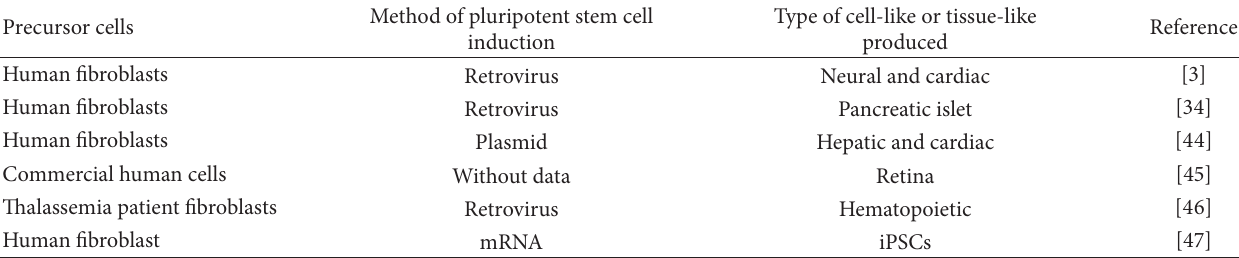
Table 2: Obtaining and differentiating human iPSCs.